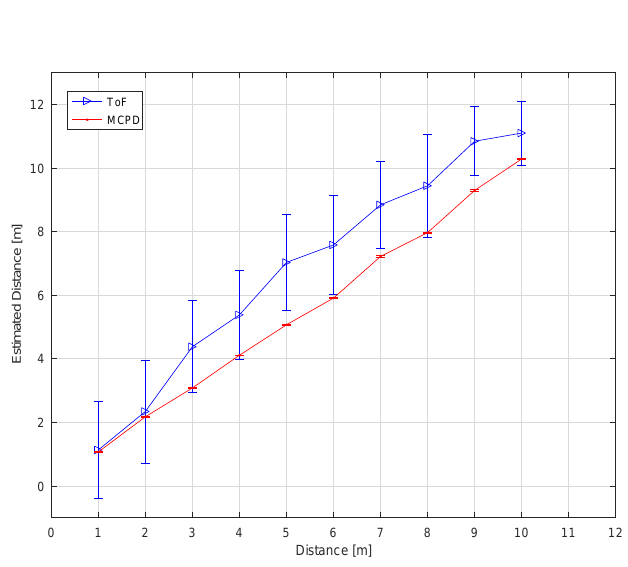
Figure 14: Outdoor distance measurement results.